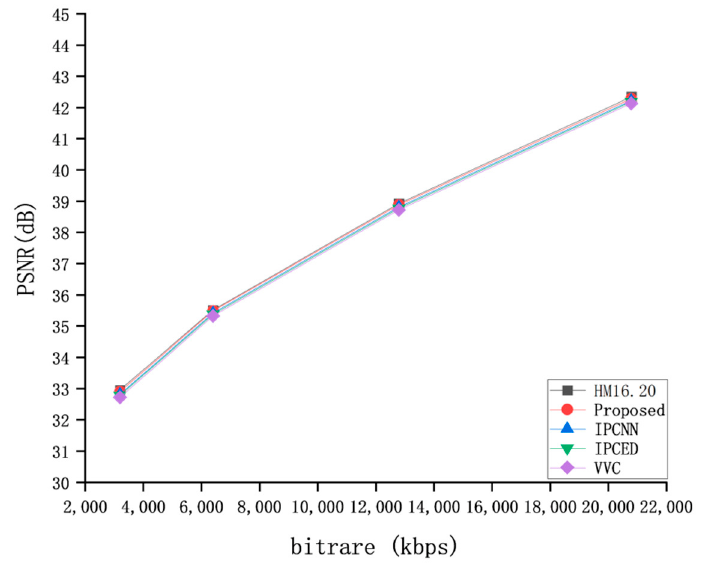
Figure 6. RD performance curve of RaceHorses sequence of each algorithm.